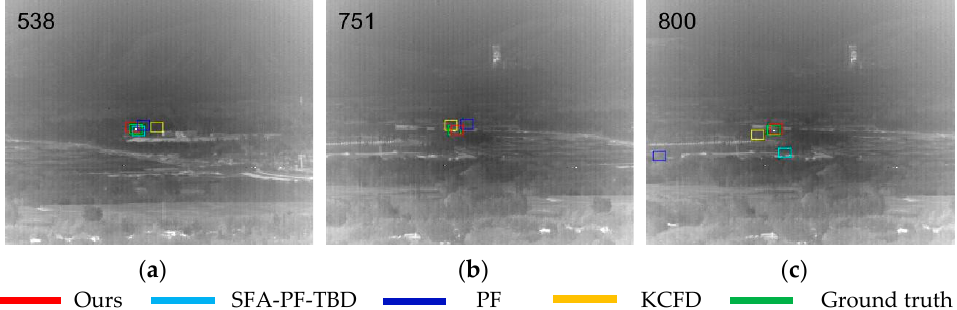
Figure 5. Tracking results of four methods for data19. ( a ) Results at frame 538; ( b ) results at frame 751; ( c ) results at frame 800.